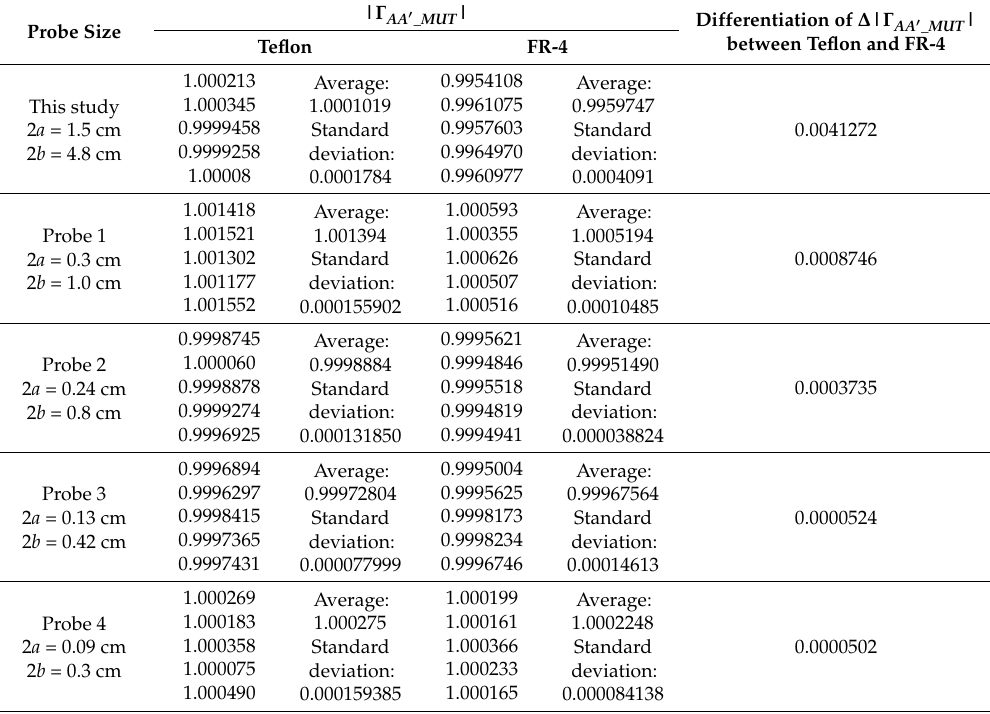
Table 2. Measured | Γ AA (cid:48) | for Teflon and FR-4 sheets with thickness of 1 mm backed by metal plate at 50 MHz.